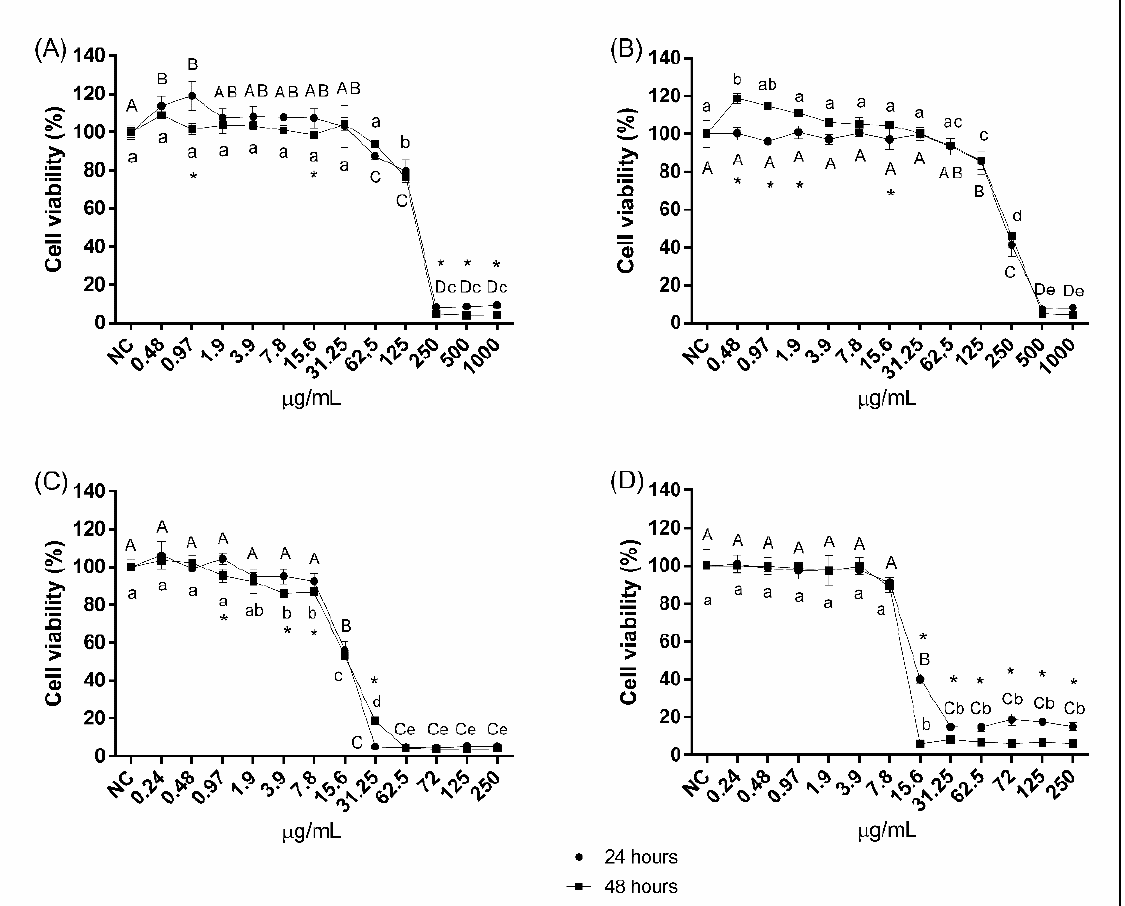
Figure 3. Percentages of viable L929 cells (murine fibroblasts) after exposure to fluconazole at 0.48–1000 µg/mL ( A ), fluconazole-containing nanocarrier at 0.48–1000 µg/mL ( B ), miconazole at 0.24–250 µg/mL ( C ), and miconazole-containing nanocarrier at 0.24–250 µg/mL ( D ). Fibroblasts cultivated in drug-free culture medium depict the negative control (NC). Different upper- and lower-case letters indicate significant differences among the concentrations of the compounds, respectively, for 24 and 48 h of exposure. * Represents significant difference between 24 and 48 h of exposure, within each concentration assessed (two-way ANOVA and Tukey’s test; p < 0.05).